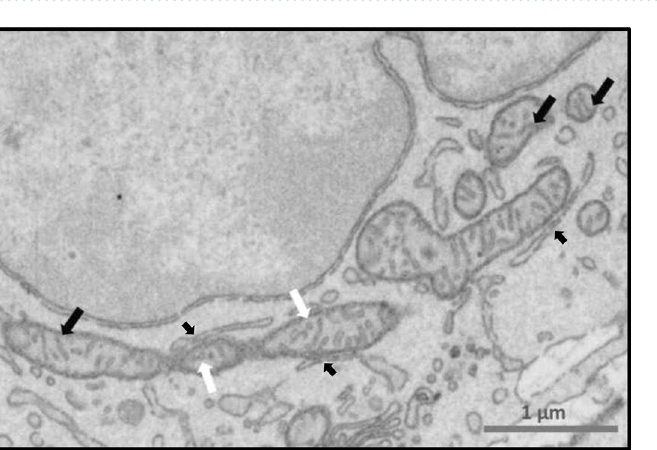
Figure 4. Cumulus cell scanning electron microscopy micrograph showing: examples of mitochondria with lamellar cristae (black arrow) and tubular cristae (white arrow). Mitochondria in the top right of the image show a developed lamellar crista connected to the inner mitochondrial membrane. Several close contacts (mitochondria-associated membranes, MAM) between mitochondria and endoplasmic reticulum in cumulus cells (small black